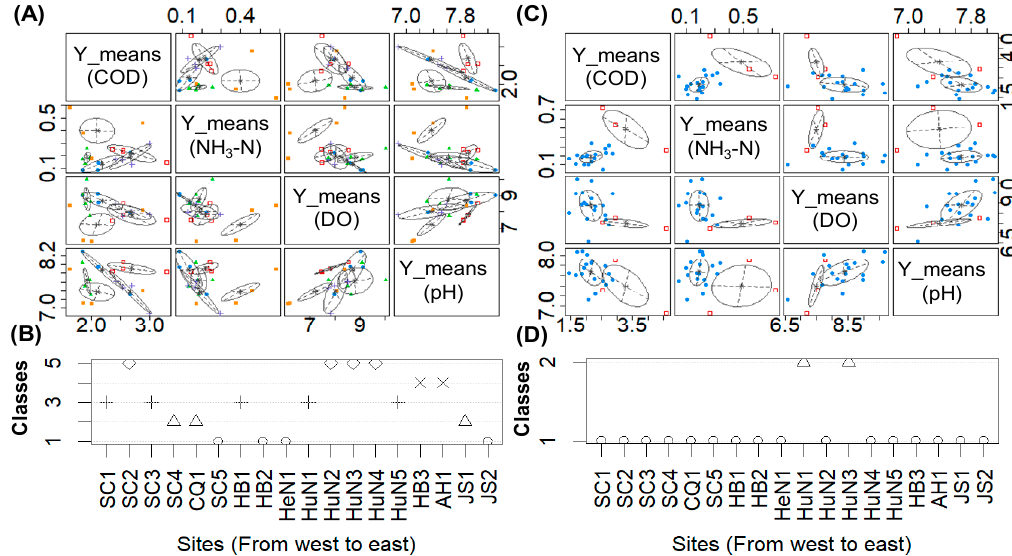
Figure 3. Classification of the 18 YRB surface water sites in 2016 ( A and B ) and 2017 ( C and D ) by expectation–maximization (EM) clustering based on the yearly means (Y_means) of chemical oxygen demand (COD), ammonia nitrogen (NH 3 -N), pH, and DO. Data distribution ( A , C ) and geographical distribution ( B and D ). (The different shapes and colors in Figure 3A,C and diamonds, x crosses, crosses, triangles, and circles in Figure 3B,D indicate different EM clusters.).